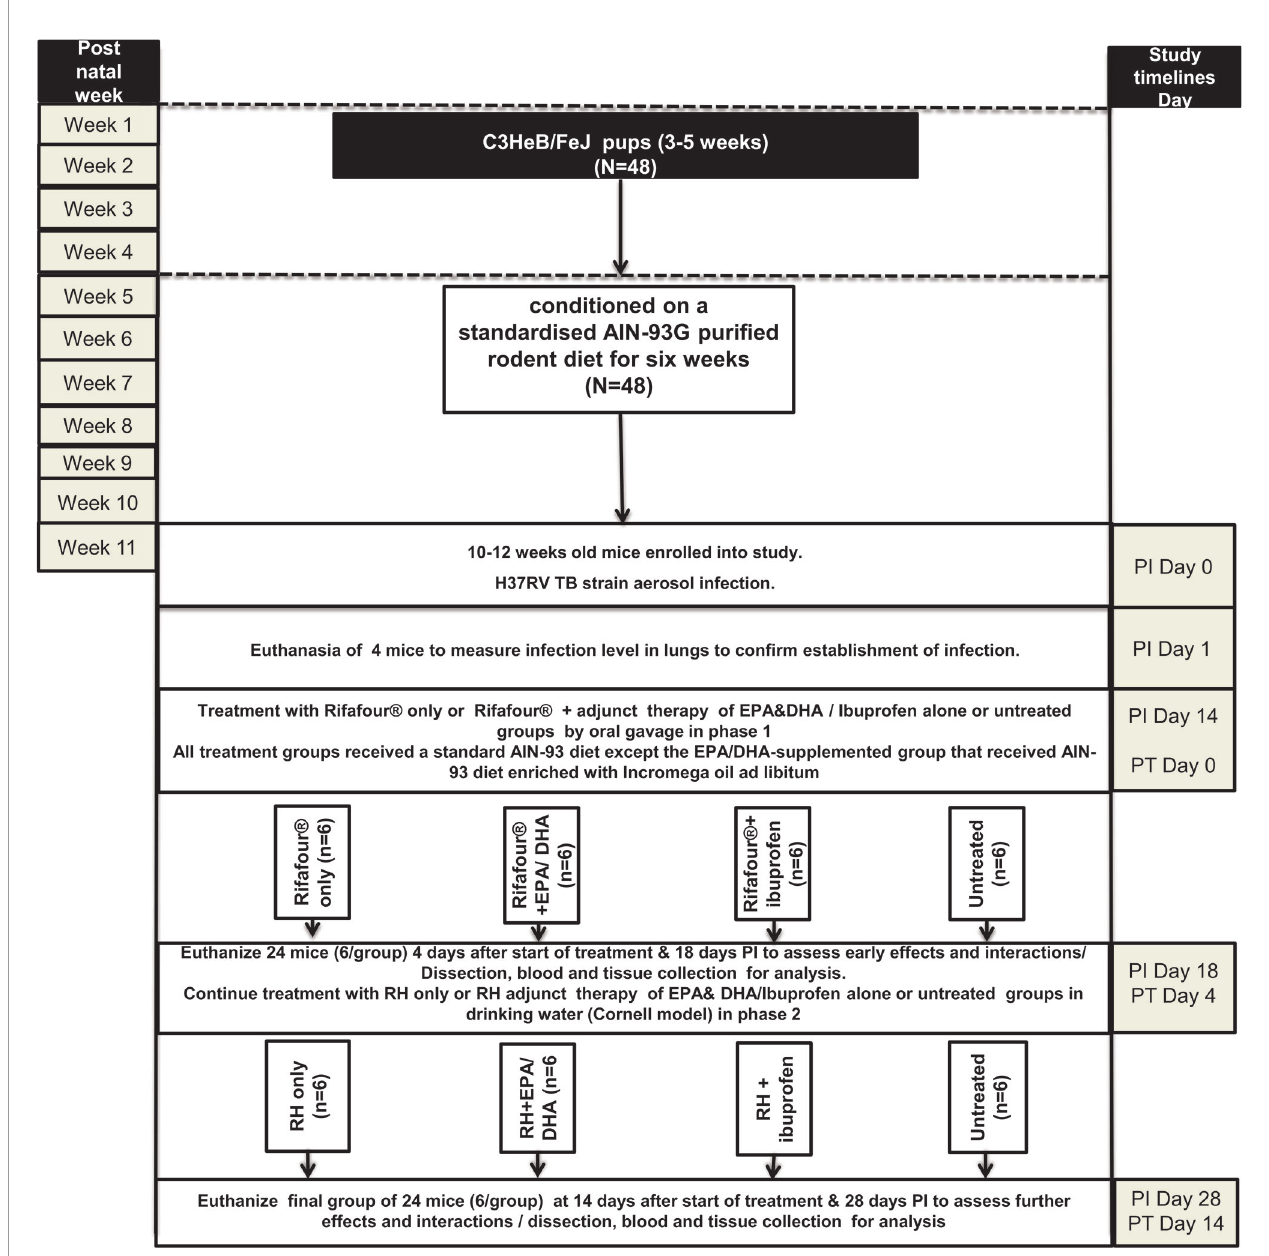
FIGURE 1 | Experimental design of the study. EPA, eicosapentaenoic acid; DHA, docosahexaenoic acid; Rifafour ® , 150 mg rifampicin + 75 mg isoniazid + 400 mg pyrazinamide + 275 mg ethambutol; RH, rifampicin and isoniazid; N, number of mice; PT: post treatment; PI: post infection; AIN-93G formulation containing soybean oil at 70 g/kg diet and hydrogenated coconut oil at 30 g/kg diet and 8 g Fe/kg (40 ppm Fe); EPA/DHA supplemented diet contains soybean oil at 70 g/kg diet, coconut oil at 27 g/kg diet, Incromega TG4030 oil DHA 500 TG SR (minimum 44% of FA as EPA; minimum 28% of FA as DHA); untreated group received no treatment throughout the entire duration of the